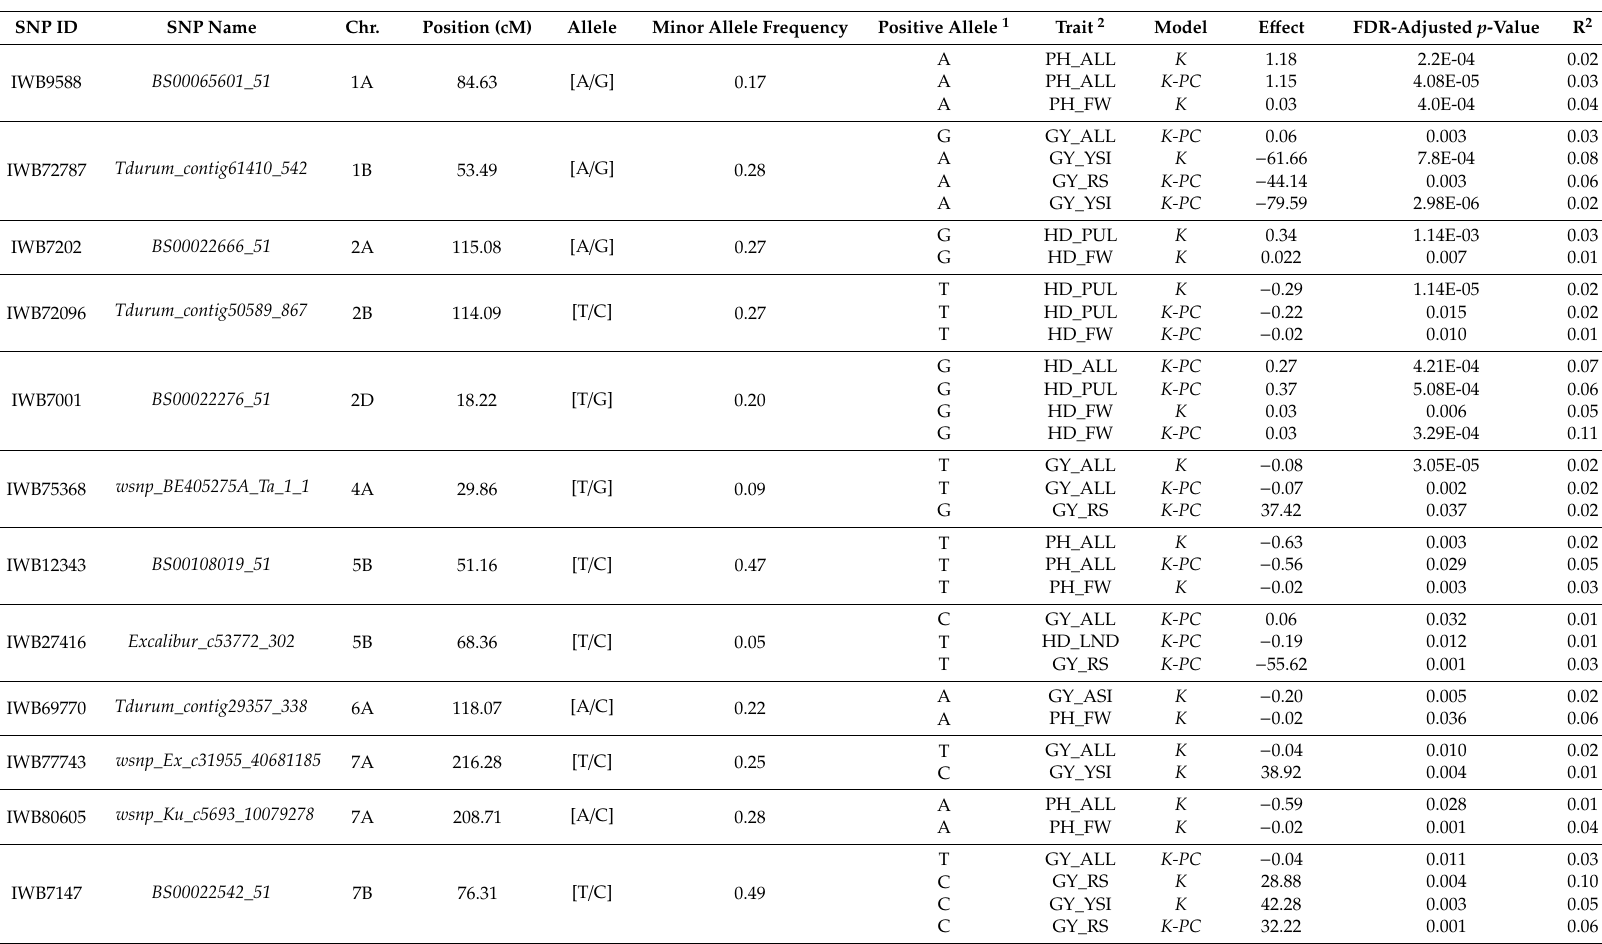
Table 4. Multi-trait loci controlling trait and stability for grain yield, heading date, and plant height in Pacific Northwest winter